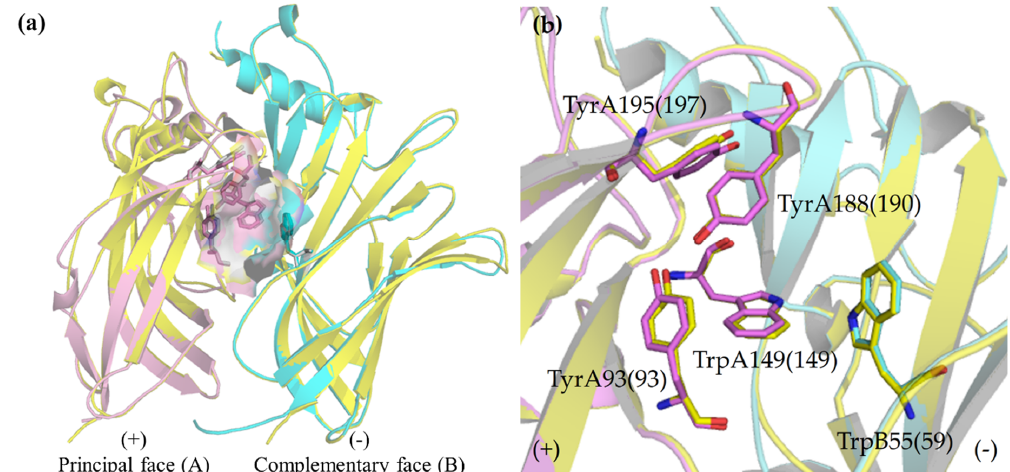
Figure 2. The overlay of ( a ) α7 and α3β4 nAChR quaternary structures with molecular surface of amino acid residues in an aromatic cage and ( b ) amino acid residues in an aromatic cage. The amino acid residues are labeled for the α7 nAChR, whereas the sequence number of residues in the α3β4 nAChR are in a parenthesis. Yellow, α7 nAChR; pink, α3 nAChR; cyan, β4 nAChR; red, oxygen; blue, nitrogen.